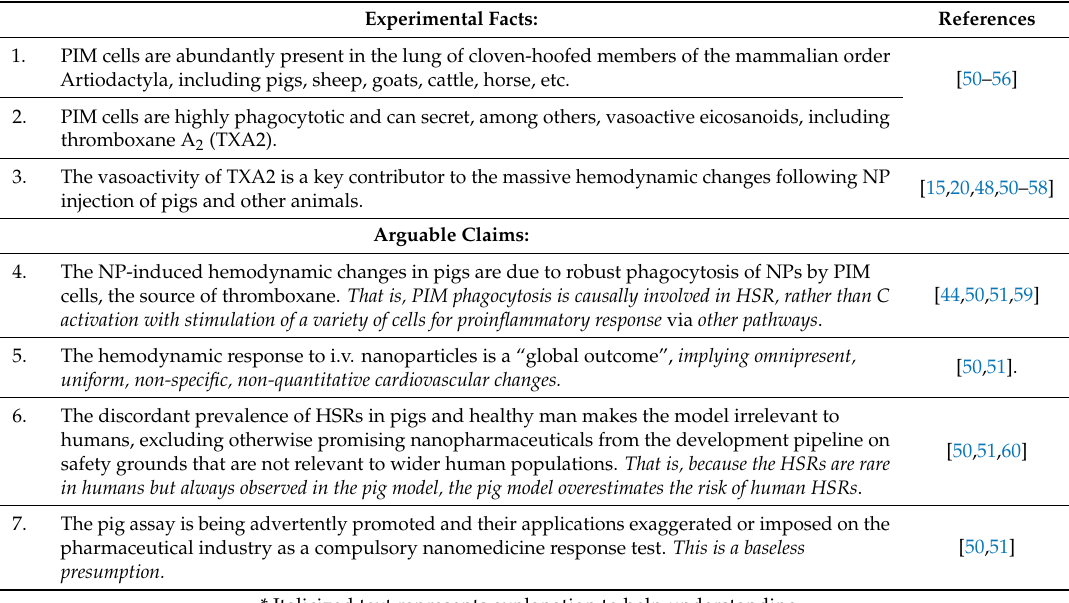
Table 2. Facts and arguable conclusions regarding the pig model of infusion reactions